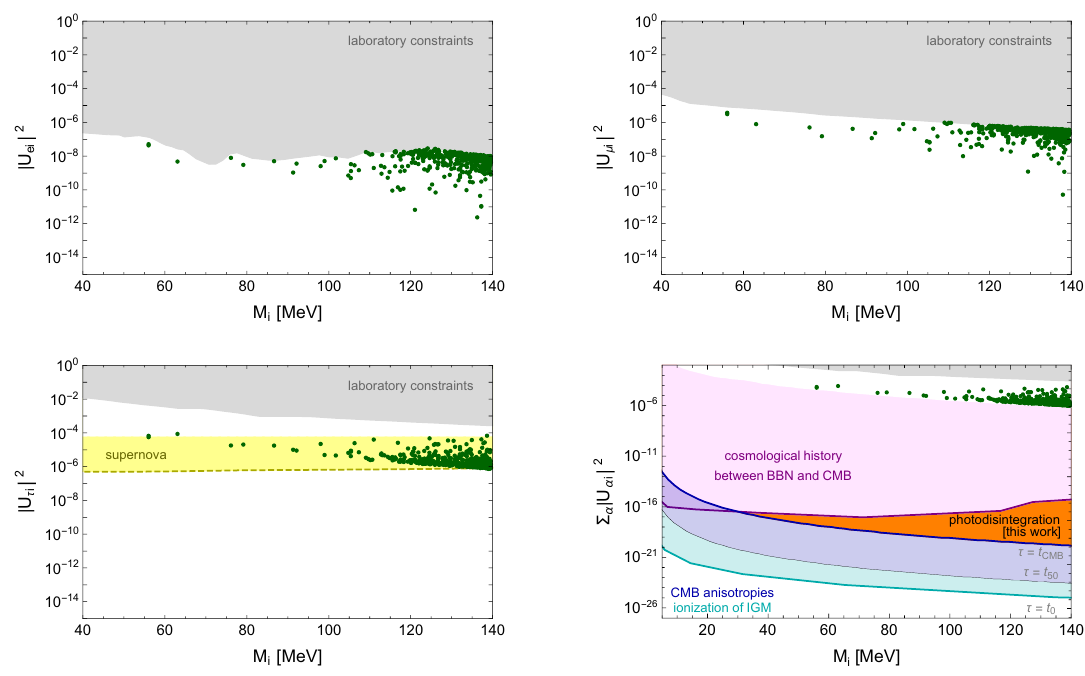
Figure 1 . Constraints on the sterile neutrino mixing with SM neutrinos. The shaded regions are excluded by laboratory constraints (grey, see section 2.1), cosmological constraints from refs. [19] (pink), [21] (blue) and [20] (cyan) (see section 2.2) and by the photodisintegration bound (orange, this work, section 2.3). The supernova constraint from ref. [55] is indicated by the yellow shaded region (see section 2.4). The green dots show realisations of neutrino masses and mixings which reproduce the neutrino oscillation data (see section 2.5). Every parameter point is represented by a triplet (one point for each N i